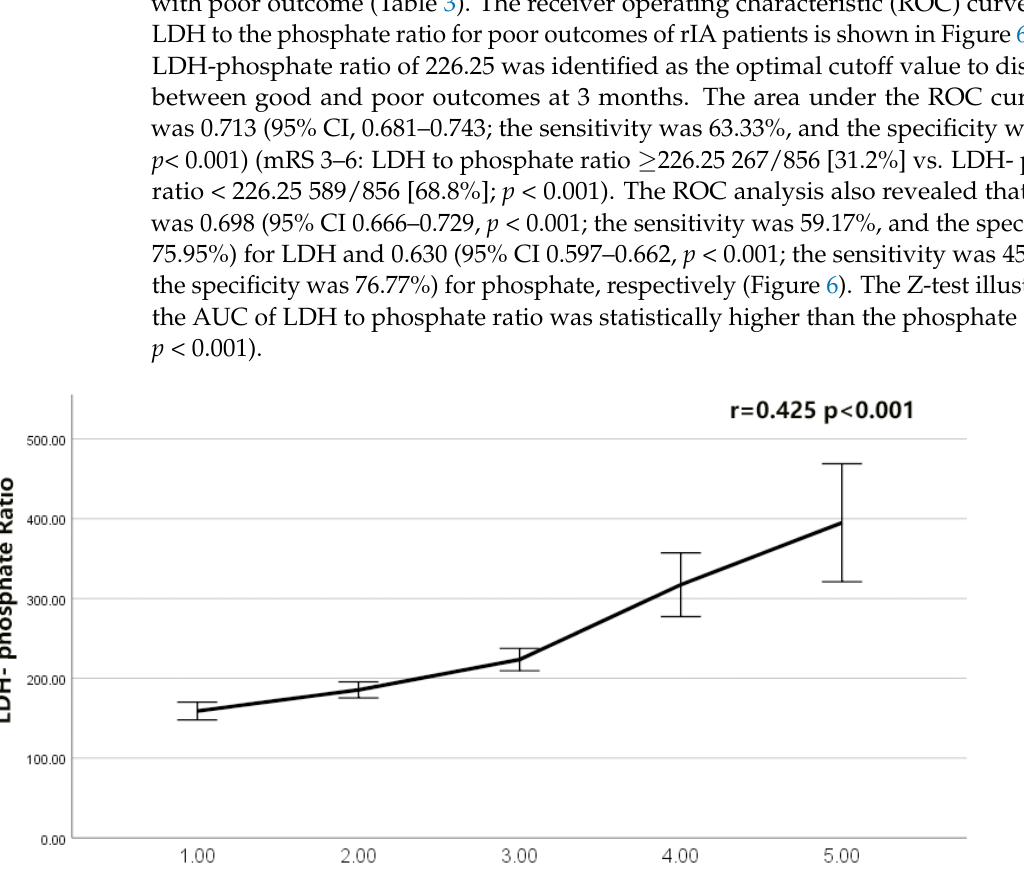
Table 3. Multivariate analysis of risk factors associated with a poor outcome at 3 months.